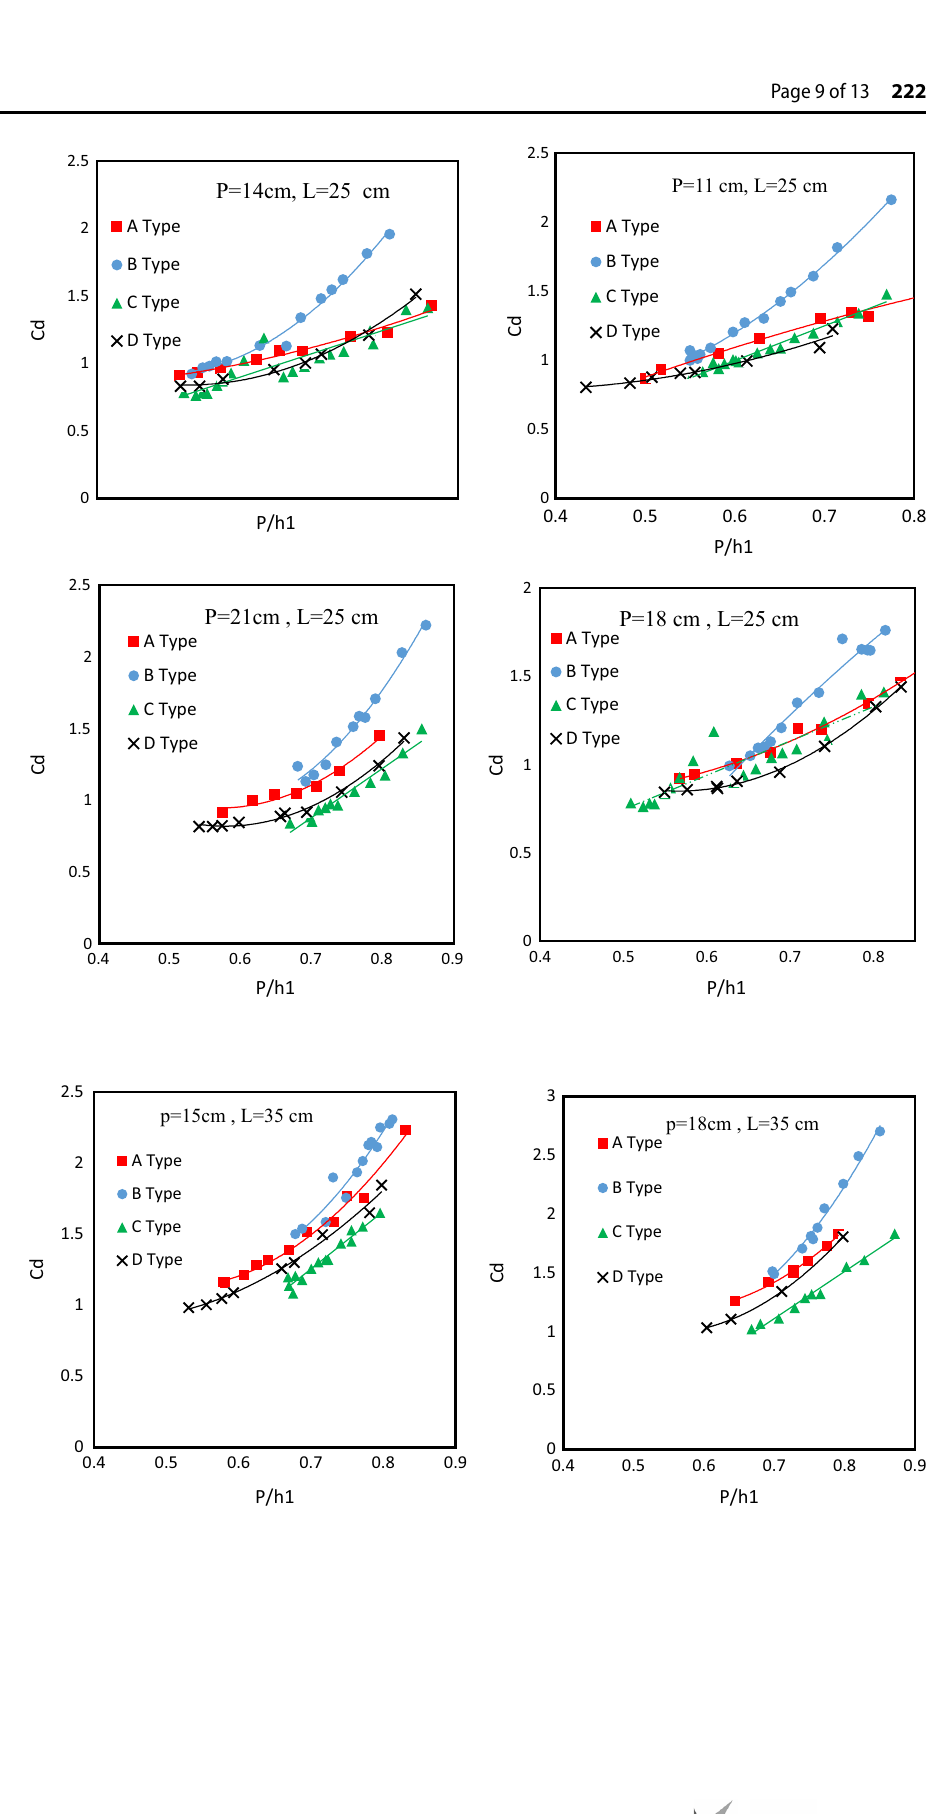
Fig. 7 Variations of discharge coefficient of RPKSW vs. the ration of P / h 1 with L = 25 cm